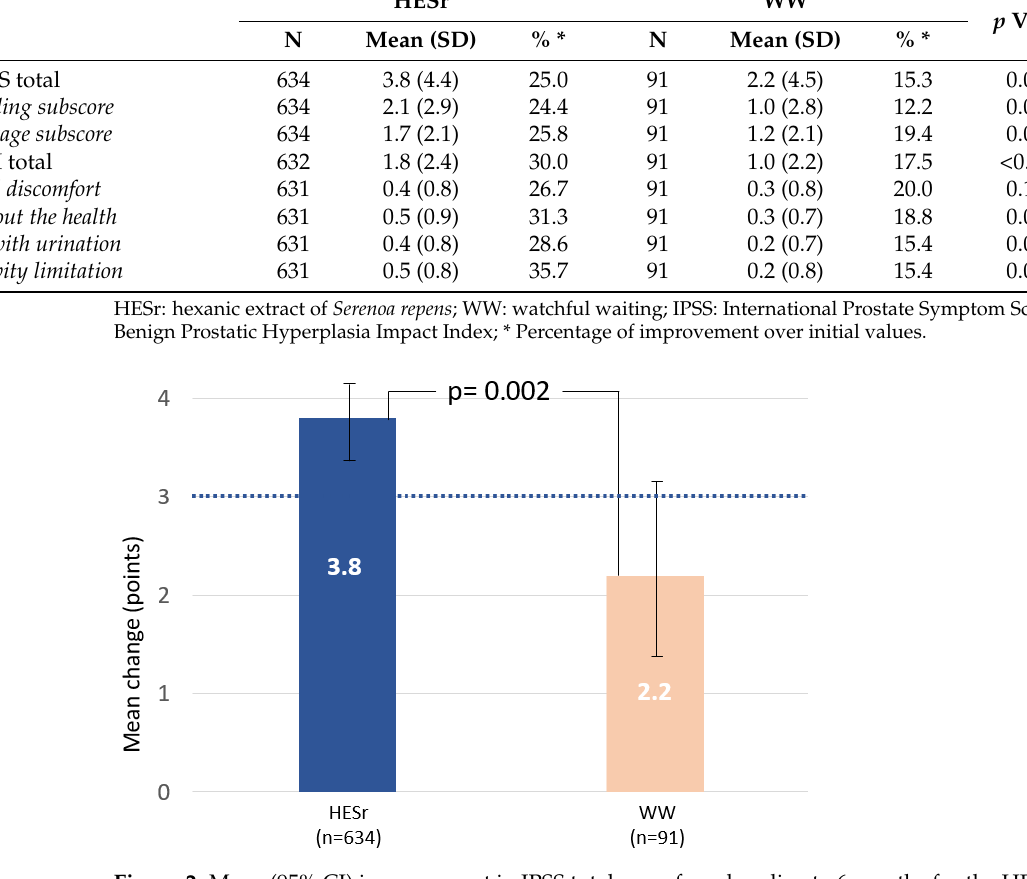
Figure 2. Mean (95% CI) improvement in IPSS total score from baseline to 6 months for the HESr and WW groups. Dotted line indicates the level at which a clinically relevant difference is observed. HESr: hexanic extract of Serenoa repens; WW: watchful waiting; IPSS: International Prostate Symptom